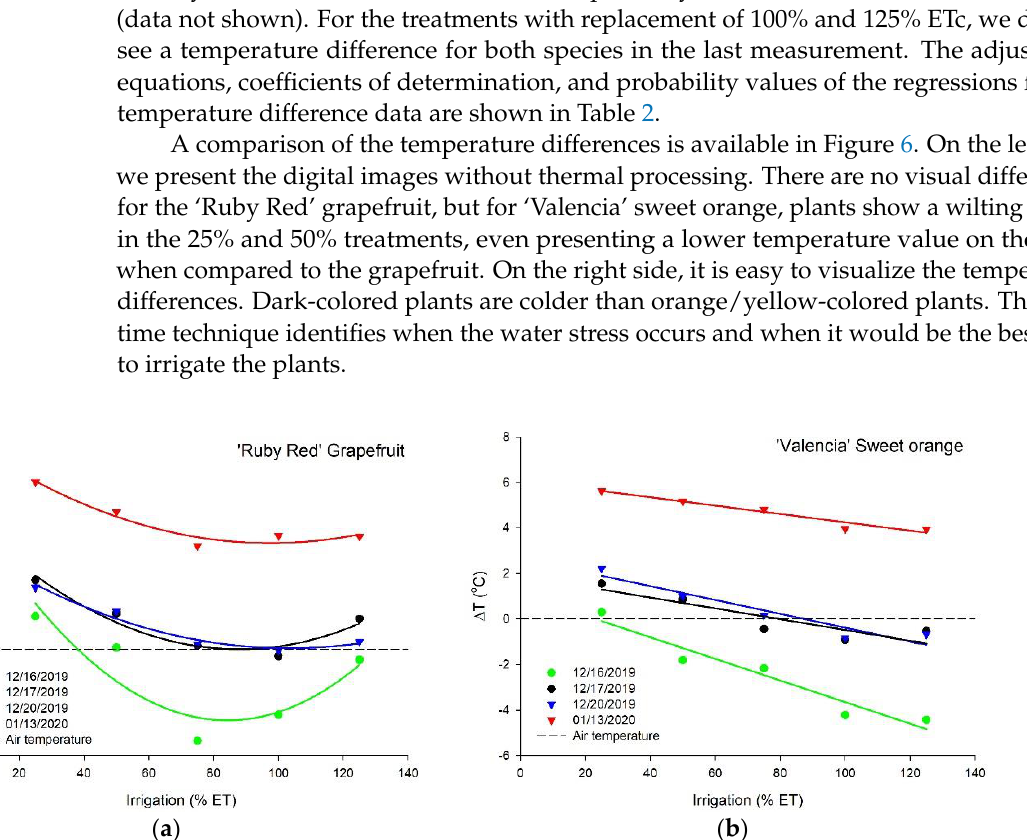
Table 2. Adjustment equations, coefficients of determination (R 2 ), and probability (P) values of the regressions for the temperature difference (∆T).